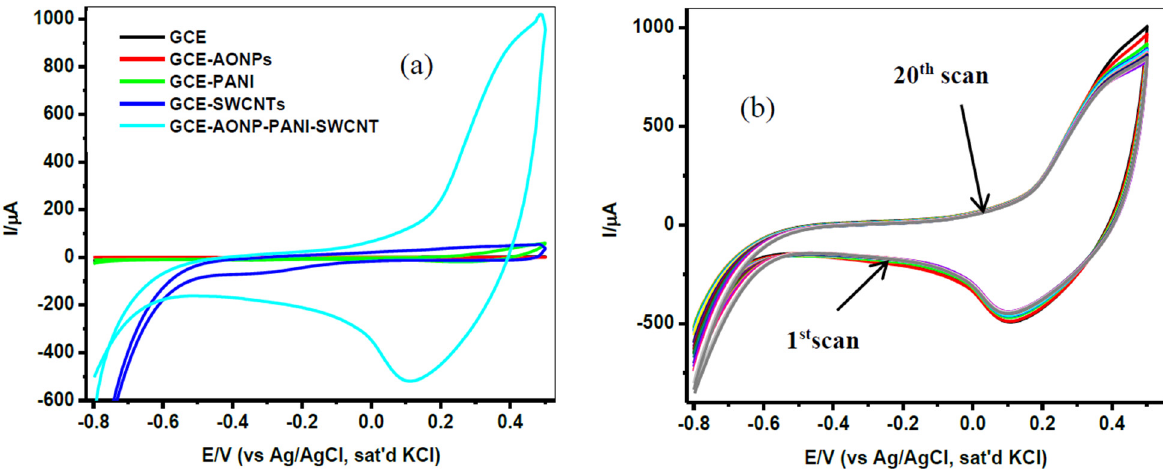
Figure 1. ( a ) Cyclic voltammograms of modified electrodes in 86 µM EDS prepared in 2:1 water/acetonitrile solution containing 0.1 M H 2 SO 4 at a scan rate of 25 mVs − 1 . ( b ) Cyclic voltammograms (20 scans) of AONP-PANI-SWCNT-modified GCE in 86 µM EDS prepared in 2:1 water/acetonitrile solution containing 0.1 M H 2 SO 4 at a scan rate of 25 mVs − 1 .